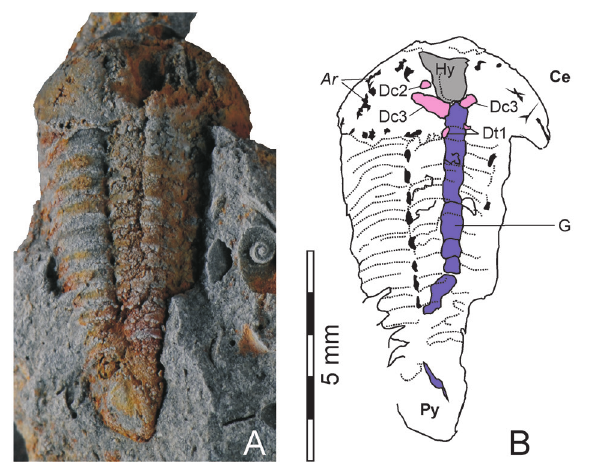
Fig. 3. Morphology of the preserved parts of the digestive system in the cephalic and thoracic regions of Colpocoryphe from the Šárka Formation (Middle Ordovician, Darriwilian = Oretanian Regional Stage). A , internal mould of Colpocoryphe cf. bohemica (Van ě k, 1965) in dorsal view; Czech Geological Survey Prague, Č GS MD 001; fields north of Rokycany (locality 2 in Fig. 1B). B , interpretative sketch of the specimen in A . Abbreviations: Ar, ichnofossil Arachnostega ; Ce, cephalon; Hy, hypostome; G, gut; Dc, cephalic gut diverticulae; Dt, thoracic gut diverticula.